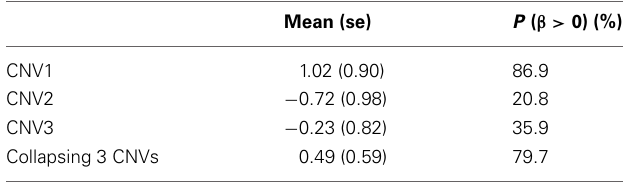
Table 3 | The posterior mean and standard deviation of β , and the posterior probability of ( β > 0) under the three single CNV marker models and the model with collapsing CNVs.